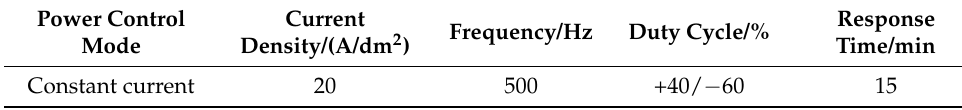
Table 3. Parameters of micro-arc